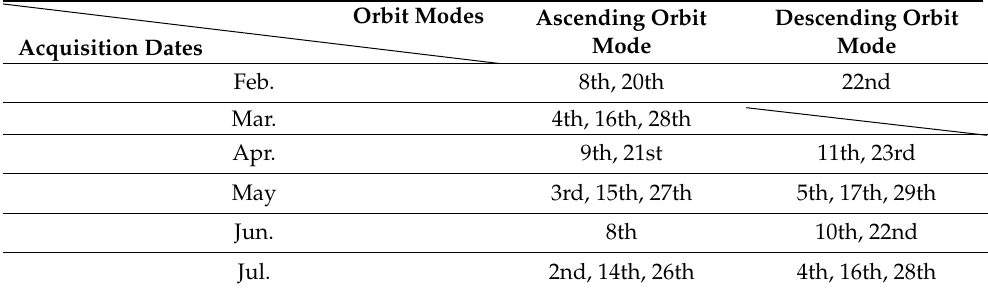
Table 2. The complete acquisition dates of research data from Sentinel-1A with ascending and descending orbit modes in 2017,